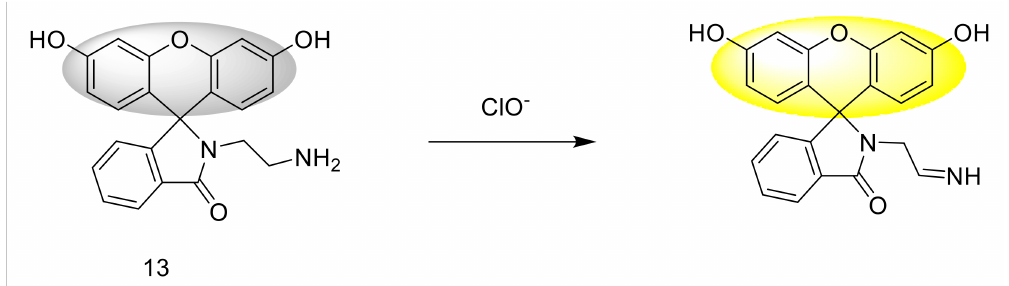
Figure 15. The reaction of probe 13 and ClO −